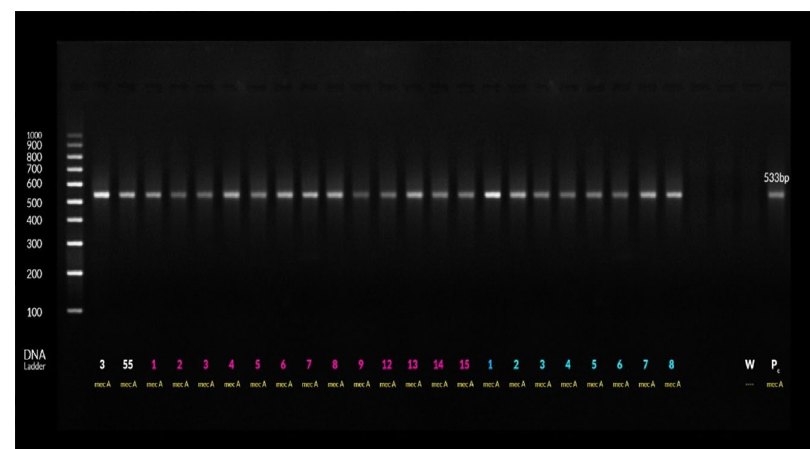
Fig. 1. Gel electrophoresis of mecA gene amplification shows mecA bands at 533bp